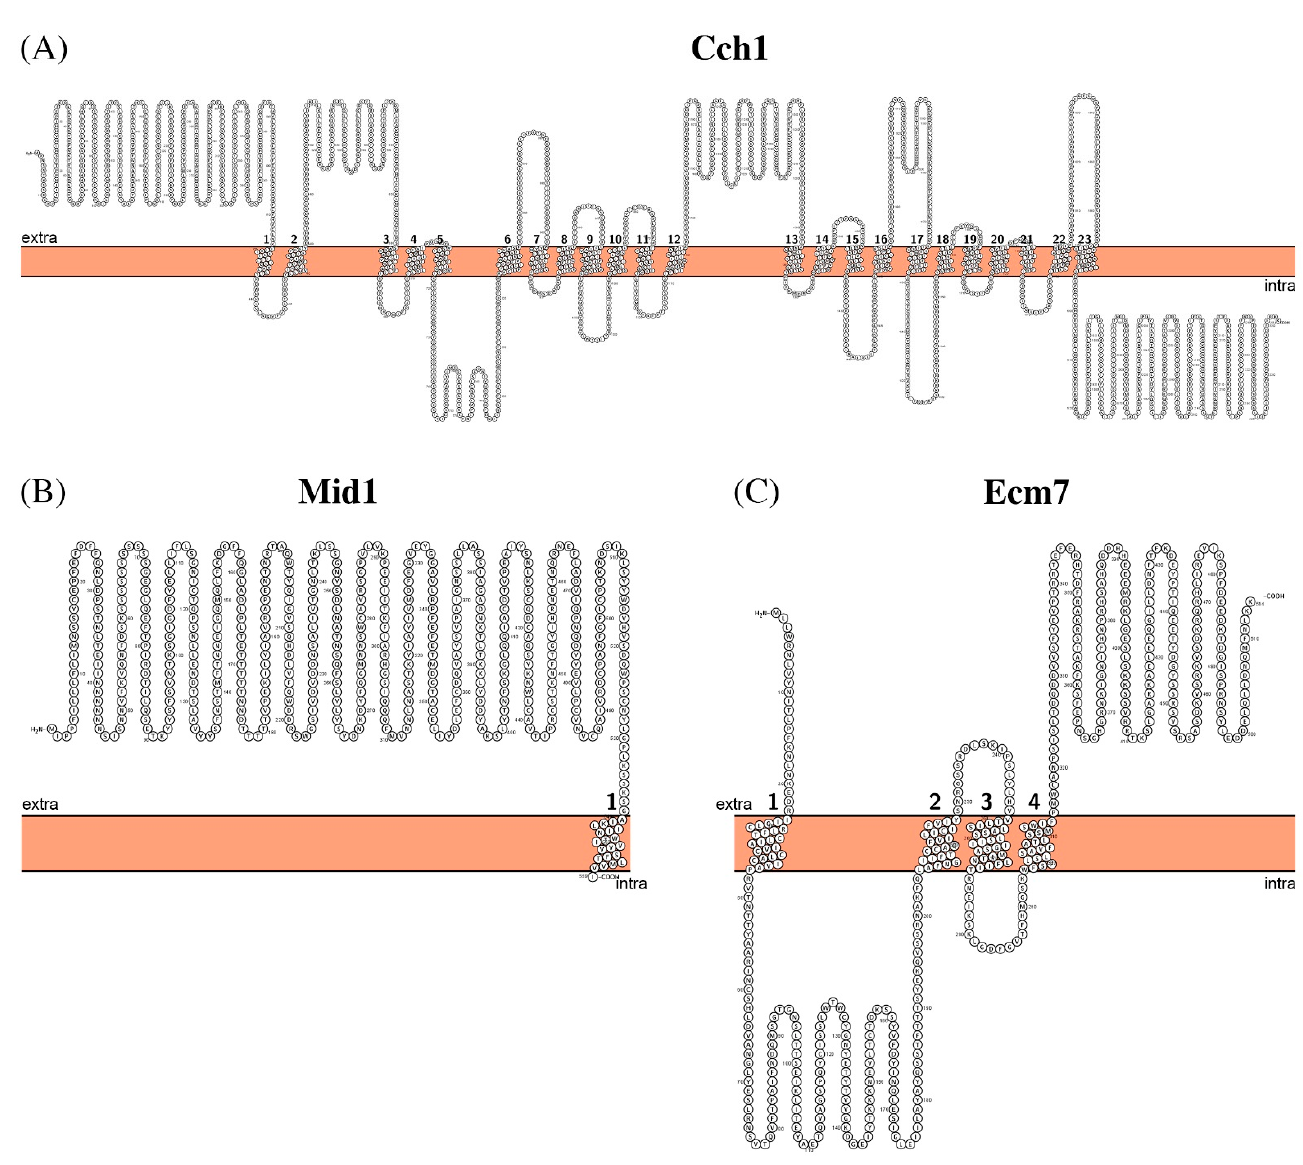
Figure 4. Schematic representation of the proposed secondary structure and topology of Cch1 ( A ), Mid1 ( B ), and Ecm7 ( C ).